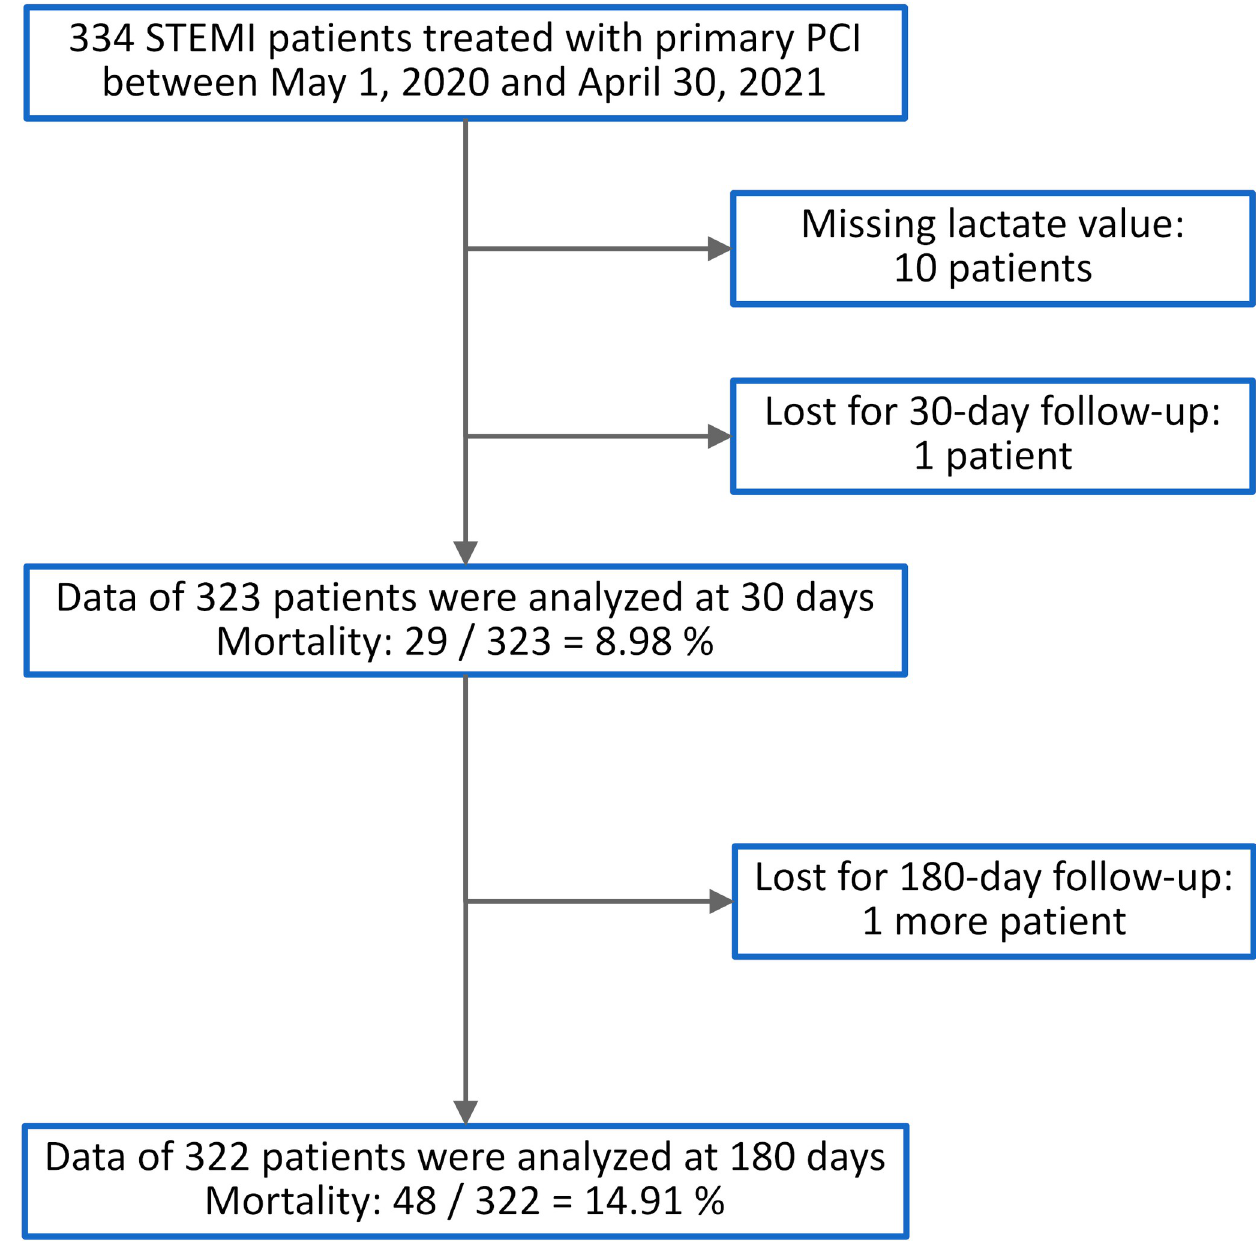
Fig 1. Patient flow chart. For details: see text. PCI: percutaneous coronary intervention; STEMI: ST-segment elevation myocardial infarction.